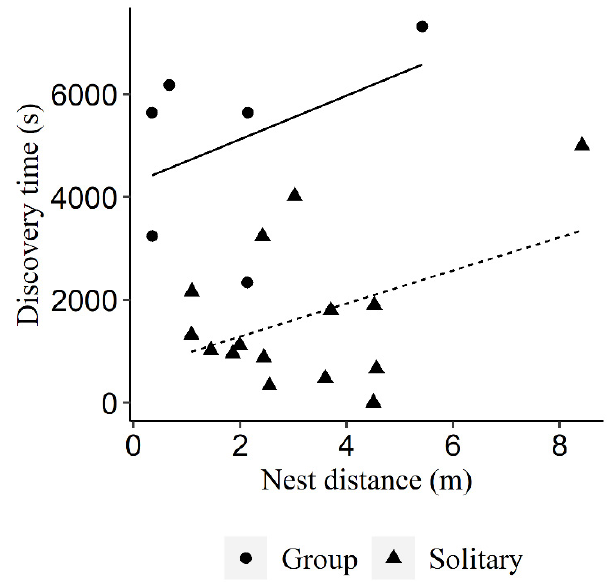
Fig 1 . Smaller ants remove diaspores in groups, and larger ants remove diaspores alone. The x -axis indicates the removal strategy, and the y -axis indicates the ant body size in millimetres. The centreline of each boxplot indicates the median of all values, and the boxes indicate the first quartile (median of the values above the central median) and third quartile (median of the values below the central median). The vertical lines of each boxplot are the Tukey-style whiskers (1.5 × interquartile range). The circles above each boxplot are outliers.